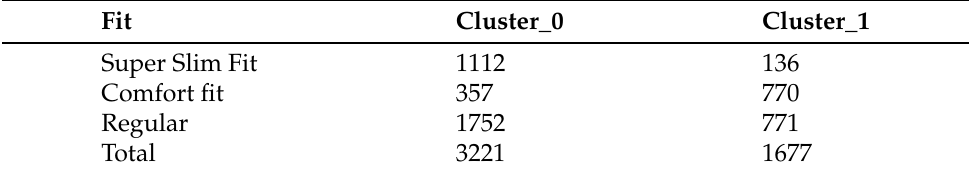
Table 1. Detailed description of clustered